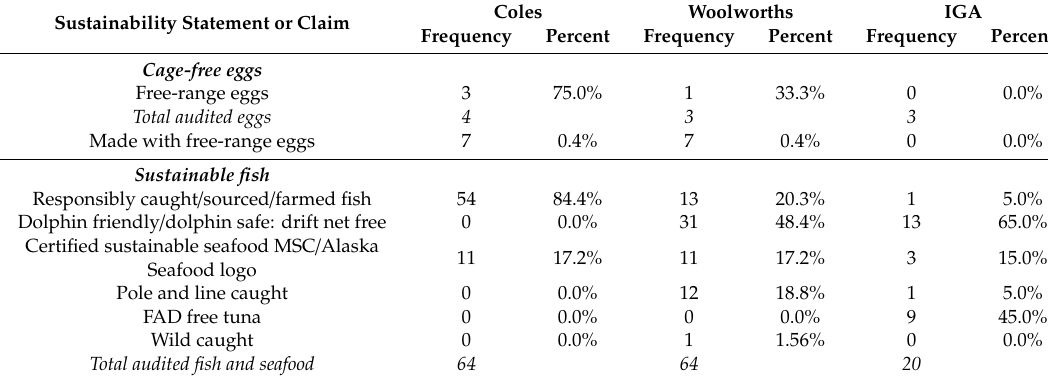
Table 4. Sustainability statements and claims present on Australian supermarket own brand foods: animal